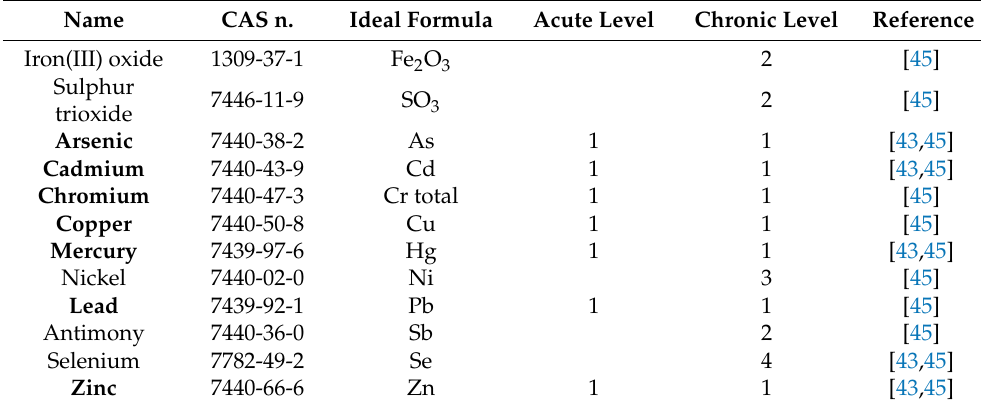
Table 4. Classification of components by acute and chronic hazards [44].